Question: Sum up the contents of this chart in one sentence.
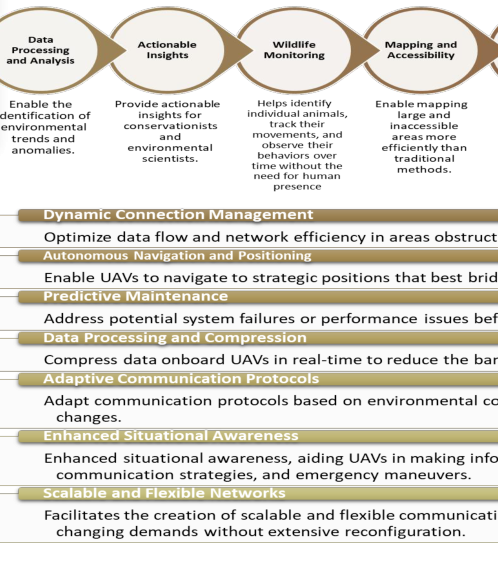
Answer: Applications of LLM-integrated UAVs.